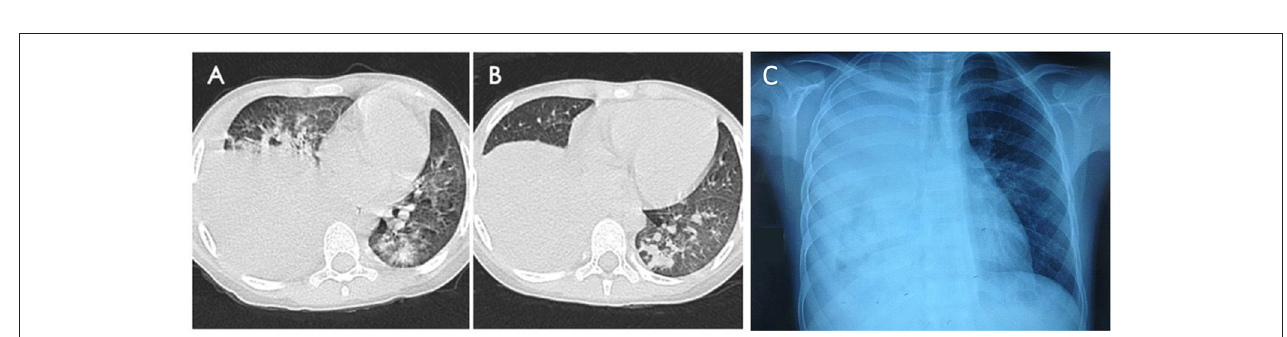
FIGURE 3 | Chest imaging revealed high-density consolidation in right lung (A,B) with right pleural effusion (C) in RMPP patients.